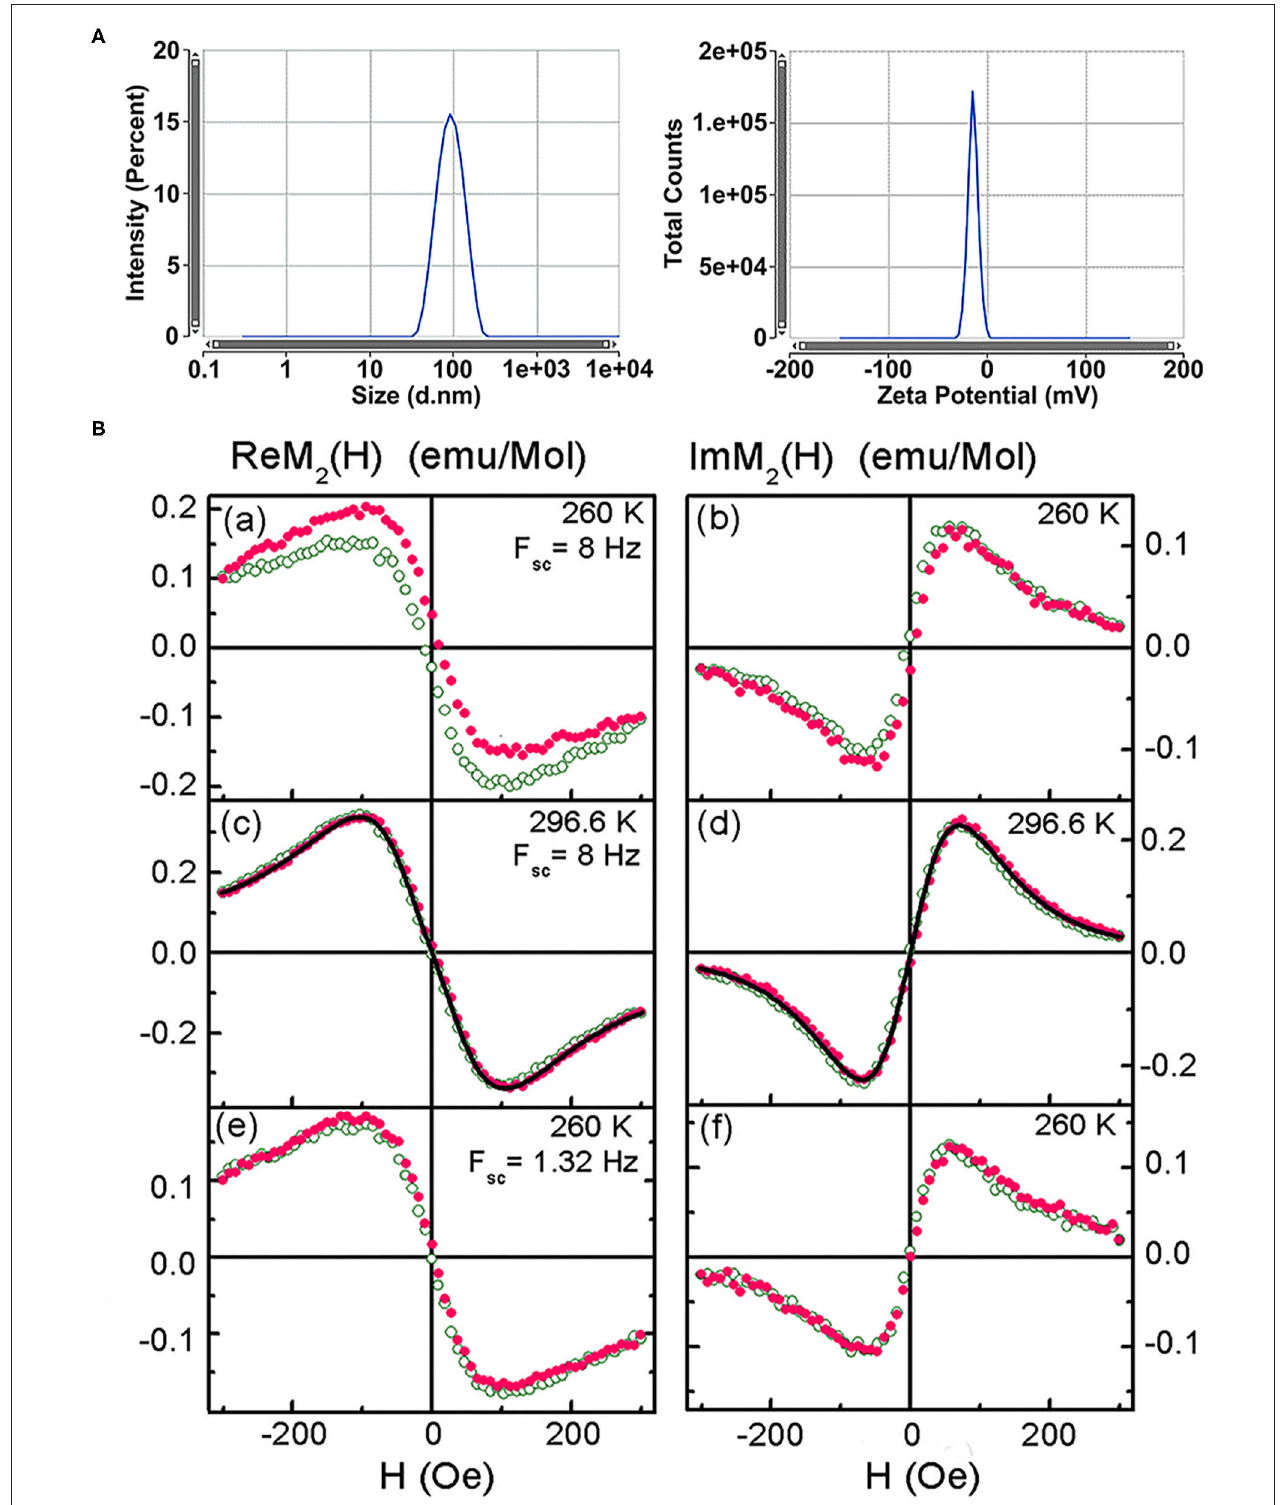
FIGURE 3 | Characterization of the superparamagnetic nanoparticles. (A) Size distribution by intensity and Zeta potential of SPIONs. (B) Real and imaginary parts of the non-linear magnetic response of the SPION aqueous suspension vs. dc magnetic field, direct (filled symbols) and reverse (open symbols) H scans at scan frequencies F sc 8 and 1.32Hz and temperatures 260 and 296.6K. Only every 16th point is shown. Black curves in (c) and (d) are simultaneous best fit. =